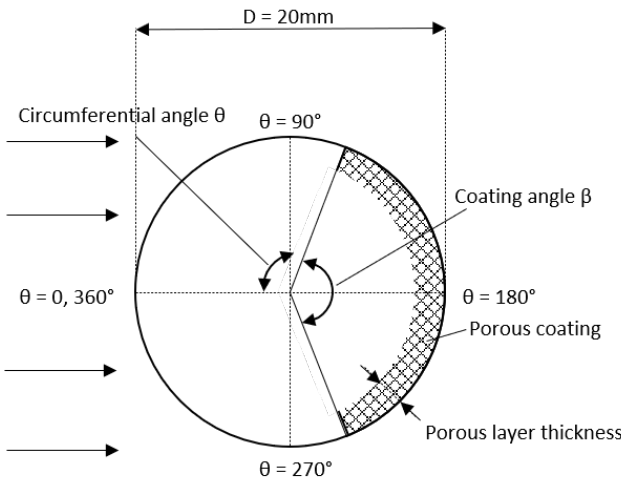
Figure 1. Schematic showing the porous coating on the leeward side of a cylinder and the definition of circumferential angle θ and porous coating angle β